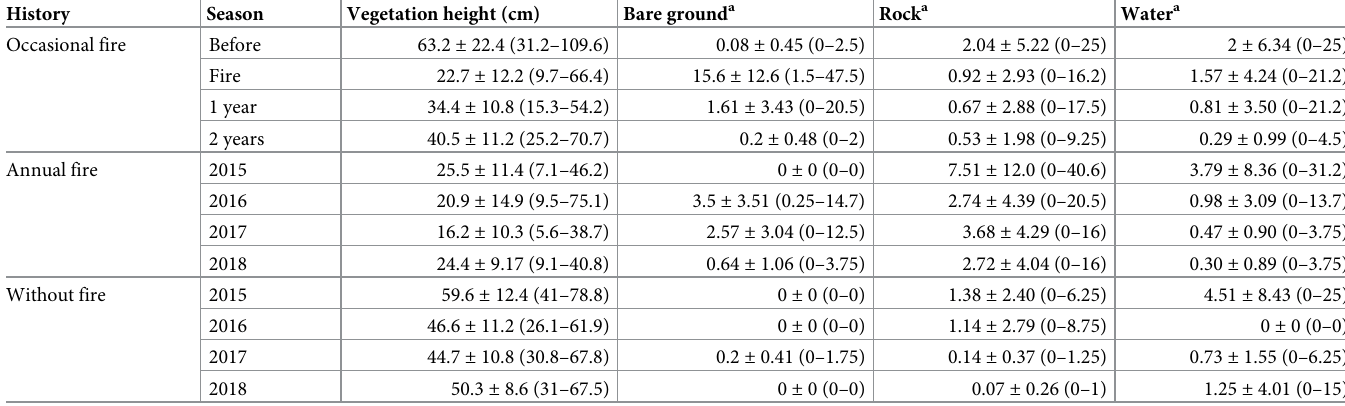
Table 2. Measurements of four environmental variables in areas with different histories of fire disturbance during four breeding seasons (2015–2018) in highland grasslands in northeastern Rio Grande do Sul state, Brazil.